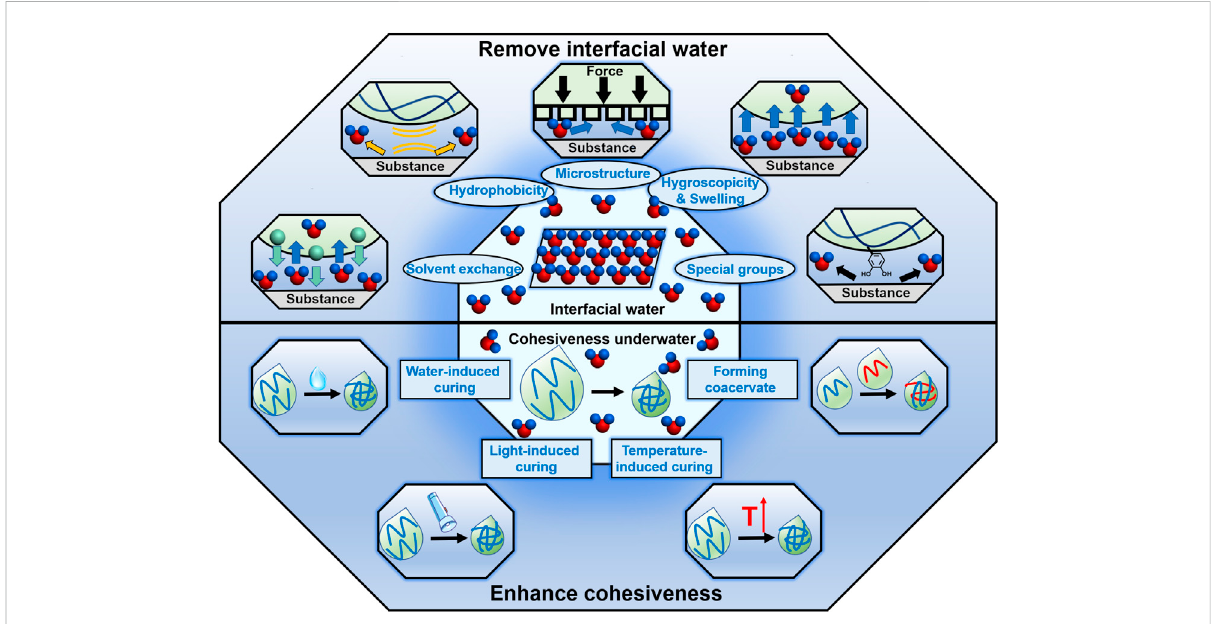
FIGURE 2 Strategiesofremovinginterfacialwaterandenhancingcohesivenessunderwater.Utilizationofthehydrophobicity,hygroscopicityandswelling property, special groups of the adhesives, solvent exchange and bioinspired microstructures are the mainly reported strategies to remove the interfacial water. And there are also many strategies to enhance the cohesiveness of the underwater adhesives, including water-induced curing, light-induced curing, temperature-induced curing and forming